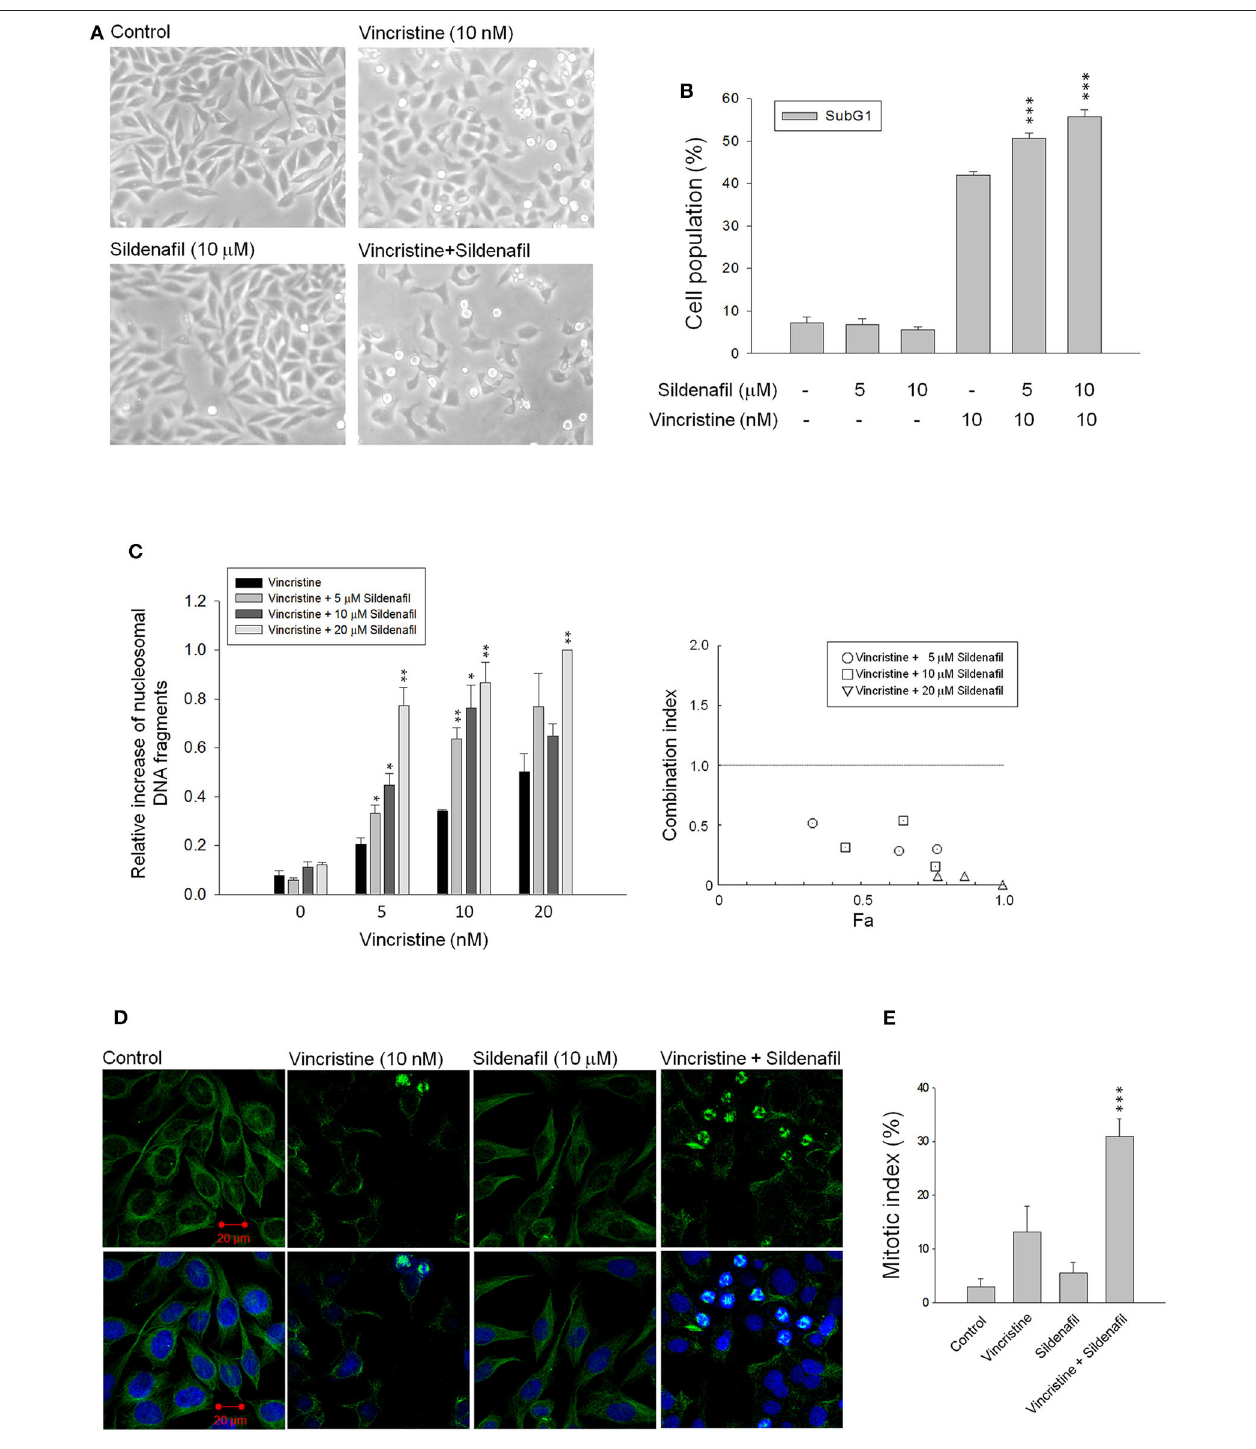
FIGURE 1 | Effect of vincristine and sildenafil on cell morphology, apoptosis, and mitotic index in PC-3 cells. The cells were incubated in the absence or presence of the indicated agent for 24h (A,C–E) or 48h (B) . The cell morphology was observed under microscopic examination (A) , or the cells were harvested for propidium iodide staining to analyze the distribution of cell populations at sub-G1 (apoptosis) phase using FACScan flow cytometric analysis (B) , or the cell apoptosis was examined through measuring the level of nucleosomal DNA fragments (C) . The confocal immunofluorescence examination was performed to detect microtubule (green) and chromosome (blue) using β -tubulin antibody and DAPI (D) , and the quantitative mitotic index was obtained accordingly (E) . Data are expressed as mean ± SEM of three to nine independent determinations. * P < 0.05, ** P < 0.01, and *** P < 0.001 compared with vincristine alone.